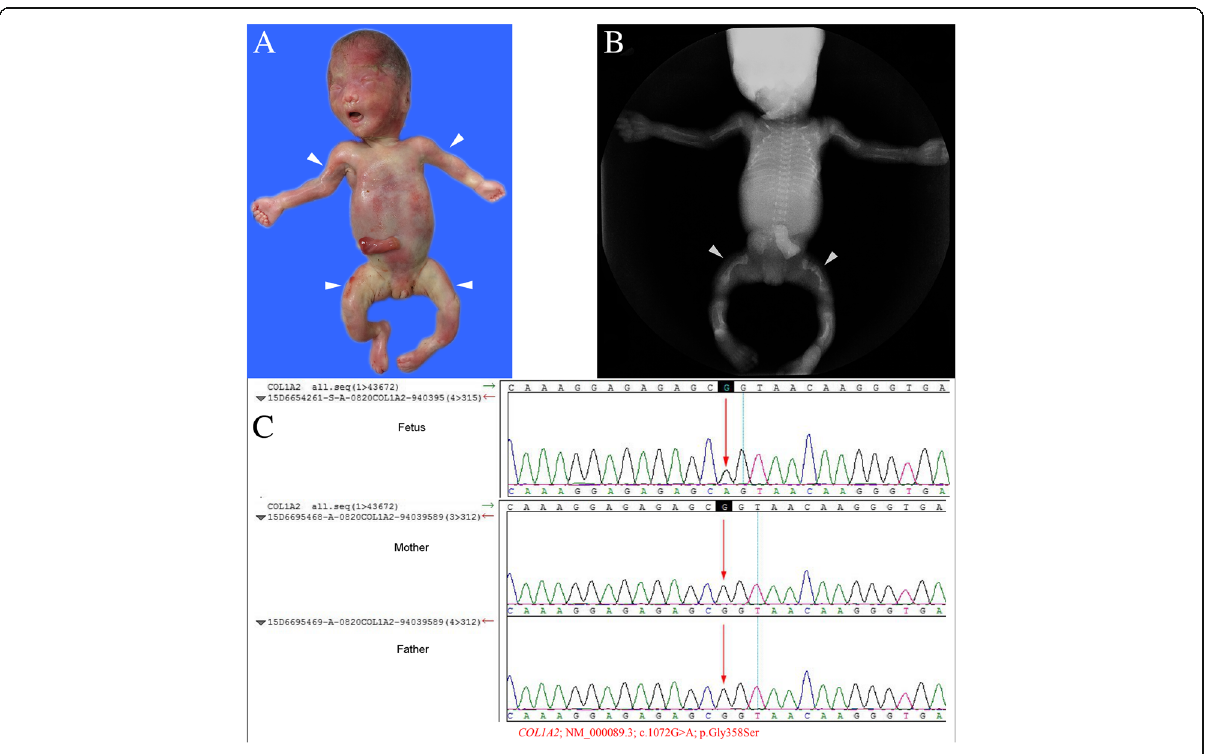
Fig. 2 Case 18: The fetus with osteogenesis imperfecta type II with collagen gene mutation (COL1A2). a Gross anatomy of the aborted fetus, showing the short arms and bending short legs (arrowheads). b X-ray images of the aborted fetus, showing the short and bent femurs, both with fractures (arrowheads). c The fetus carried the c.1072G > A (p.Gly358Ser) mutation in the COL1A2 gene. The Sanger verification revealed that this mutation was new, and was not carried by the